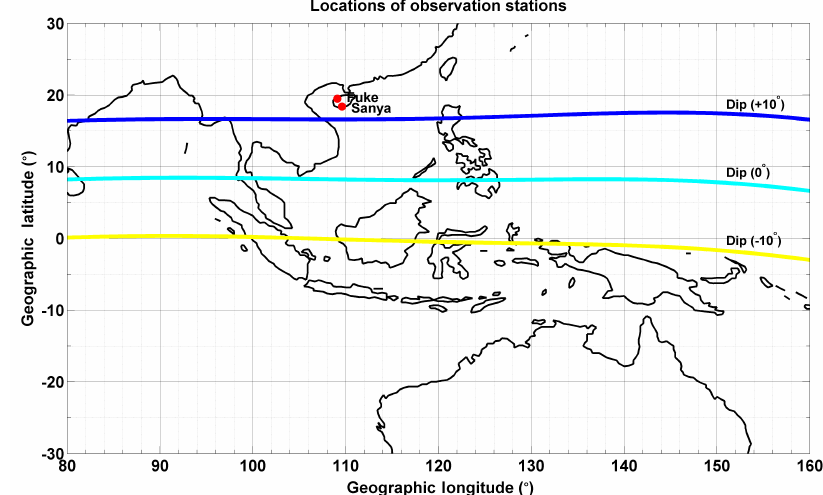
Figure 1. The location of the observation stations at Sanya and Fuke in China with the three typical magnetic latitudes (dip latitudes 10 ◦ N, 0 and 10 ◦ S) marked on the